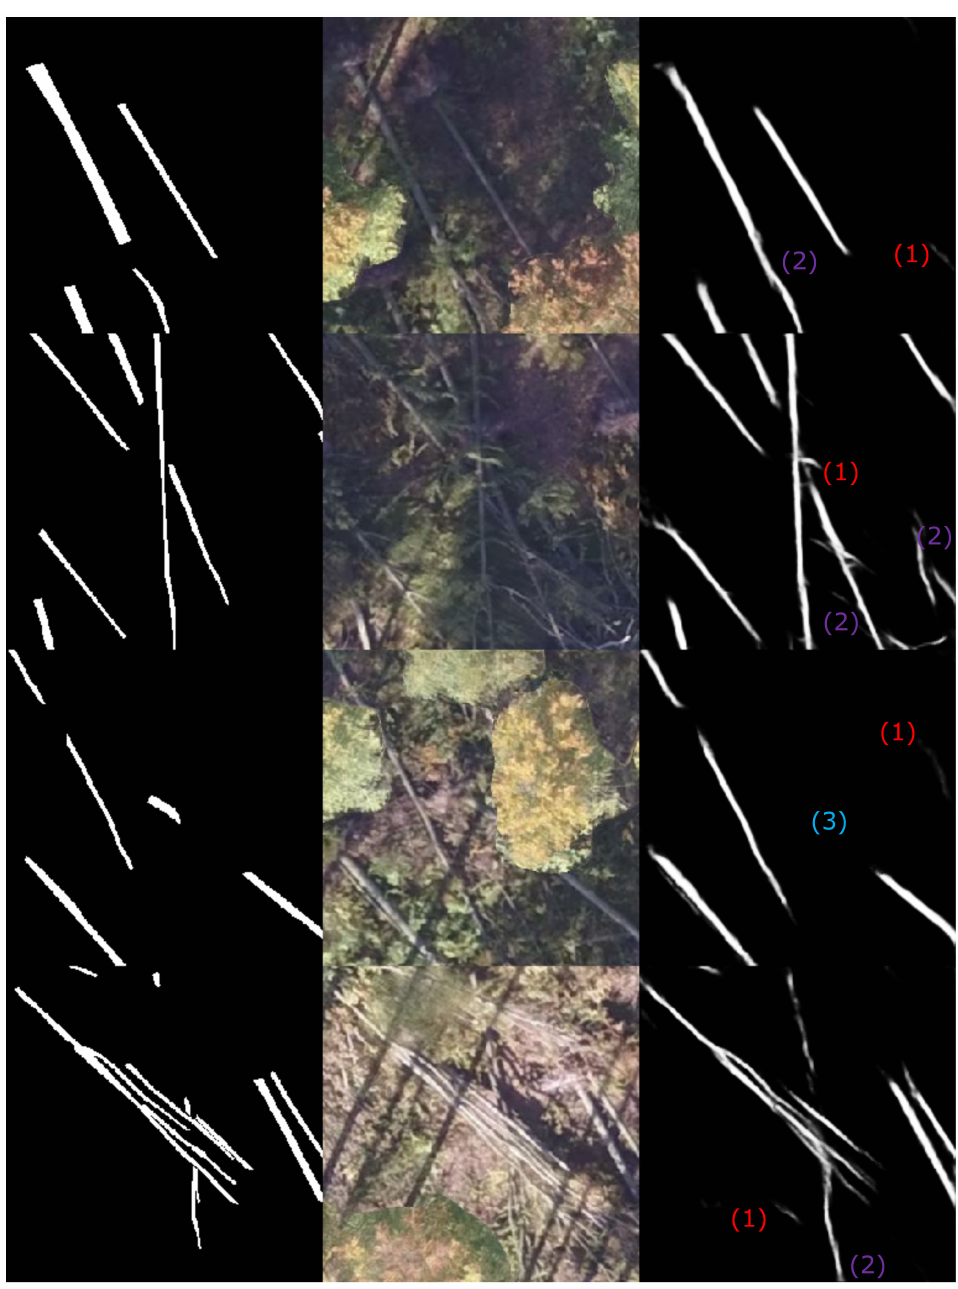
Figure 8. S2Mod10 predicted samples of the test dataset; ( left ): tree mask; middle: test samples; ( right ): predicted result. Compared to the baseline, the number of false pixels which were misinter- preted as stems pixels were reduced (1). Furthermore, the number of pixels which were detected but not present in the tree mask was increased (2). The stem parts which were not recognized in the third sample remained the same